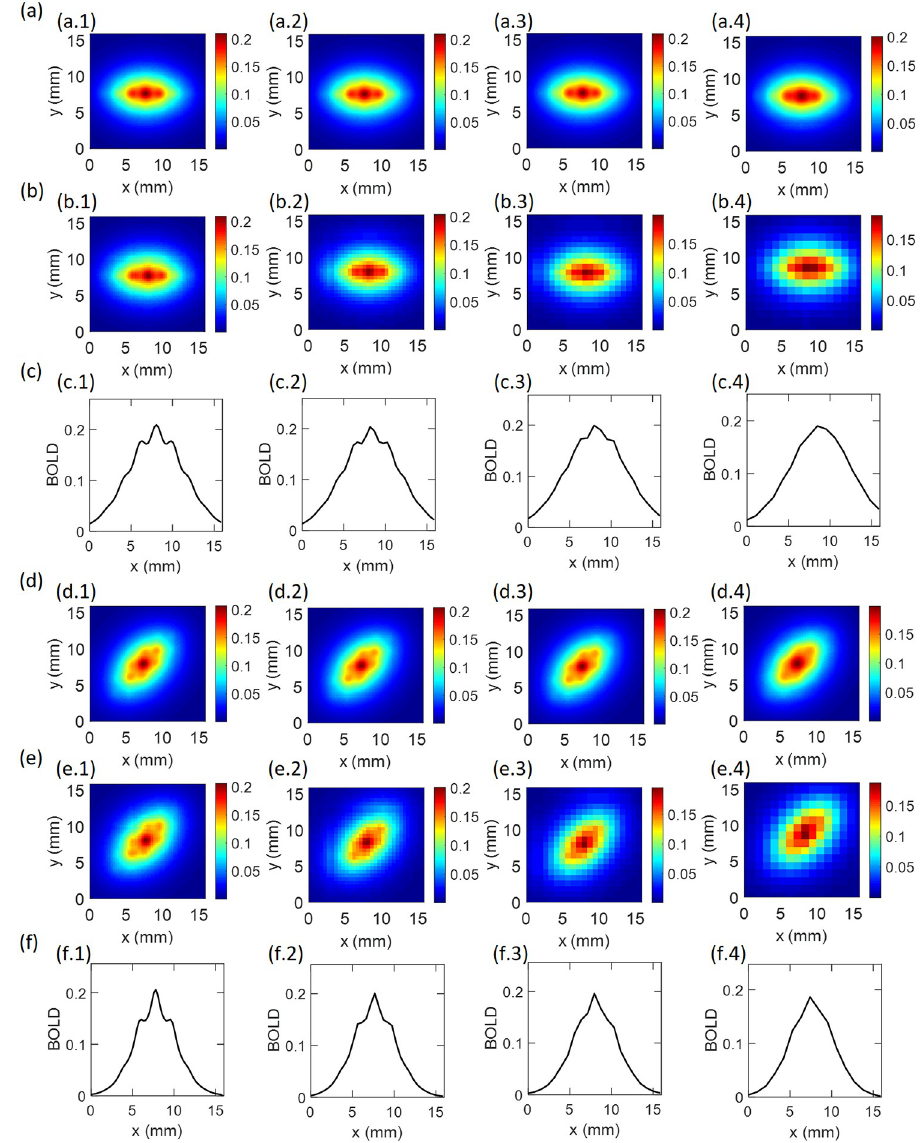
Fig 6. Coarse-grained BOLD responses for stimulus orientations of (a-c) 0˚ and (d-f) 45˚. (a,d) Smoothed BOLD response. (b,e) Pixelated BOLD response. (c,f) BOLD response profile versus distance along the OP direction. The columns are arranged from left to right to show results for resolutions of 0.25 mm, 0.50 mm, 0.75 mm, and 1.0 mm, respectively. For all panels, the profiles are taken at t = 9.7